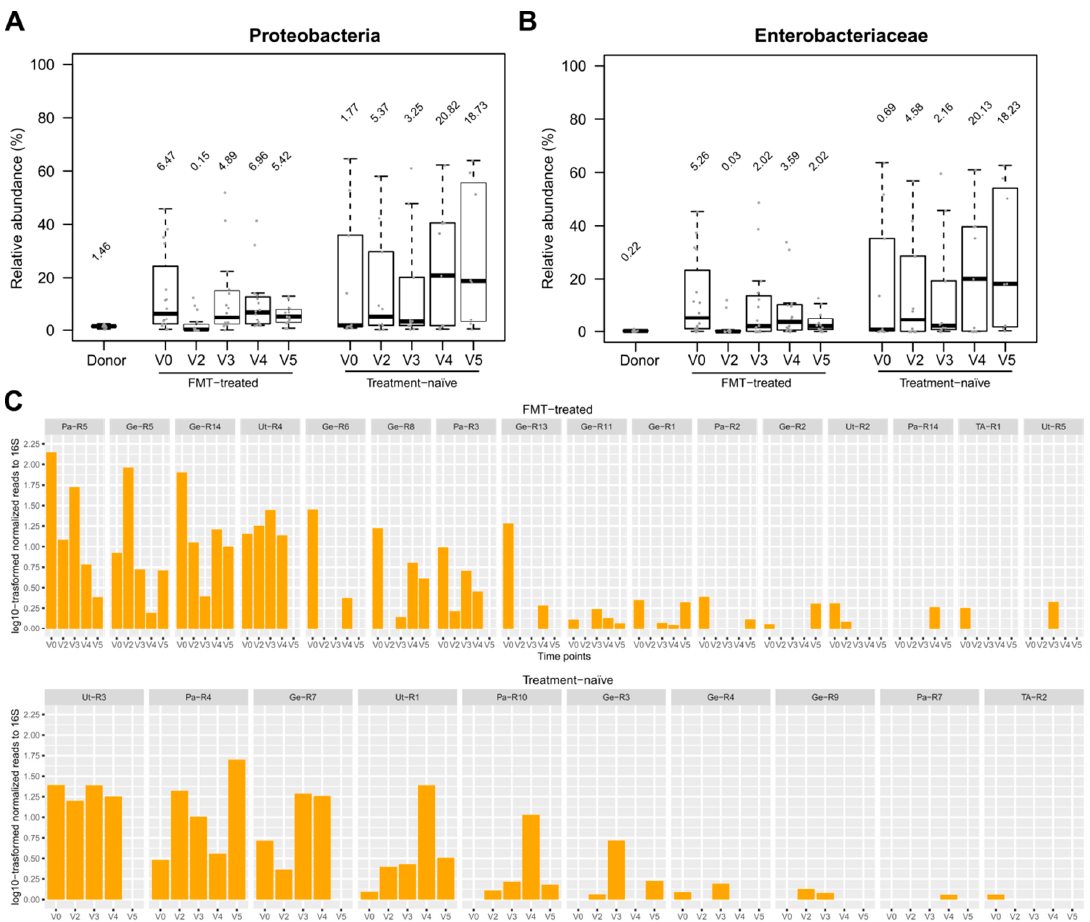
Figure 5. Effect of antibiotics/FMT treatment on the relative abundance of Enterobacteriaceae and the abundance of putative ESBL and carbapenemase genes. Boxplots combined with dotplots represent the relative abundance of Proteobacteria ( A ) and Enterobacteriaceae ( B ) in donors, FMT-treated and treatment-naïve carriers. ( C ) Counts of reads assigned to detected bla CTX-M , bla NDM , bla OXA , bla SHV and bla TEM genes were normalized to read counts of 16S rRNA genes and multiplied by 1000 prior to log10-transformation.